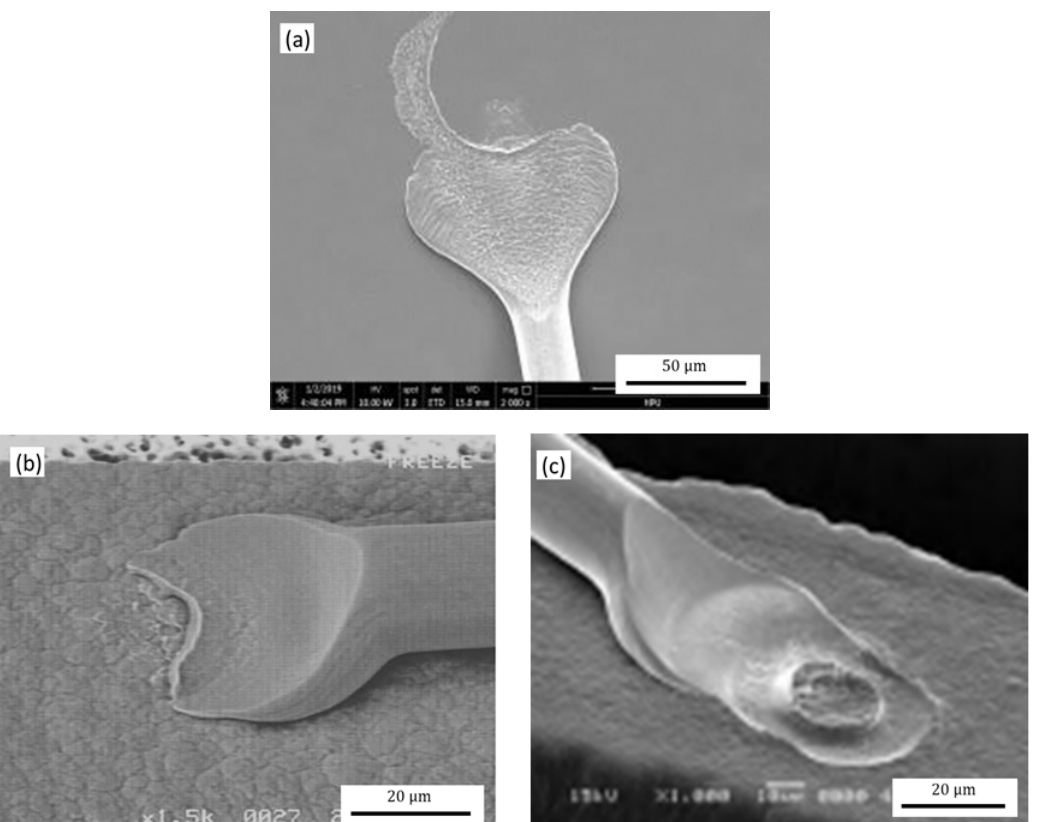
Figure 12. The morphology of the second bonded points with tip diameters (TDs) of: ( a ) 178 μ m; ( b ) 127 μ m; ( c ) 241 μ m.